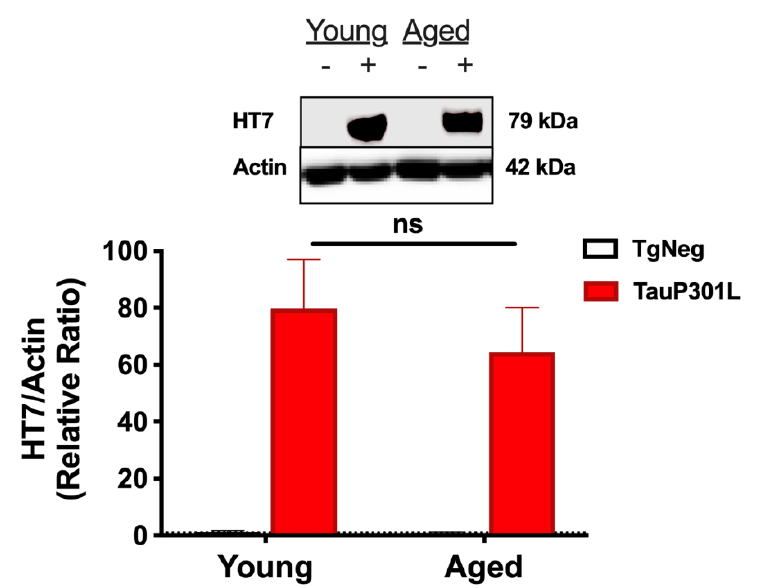
Figure 1. Tau expression. After DOX is removed, both Young- and Aged-P301L mice exhibit a strong tau expression in the hippocampus when examined using HT7, an antibody that recognizes only human tau. There is no difference between Young- and Aged- P301L tau expression for HT7. n = 5 – 7/group . − represents TgNeg and + represents P301L.